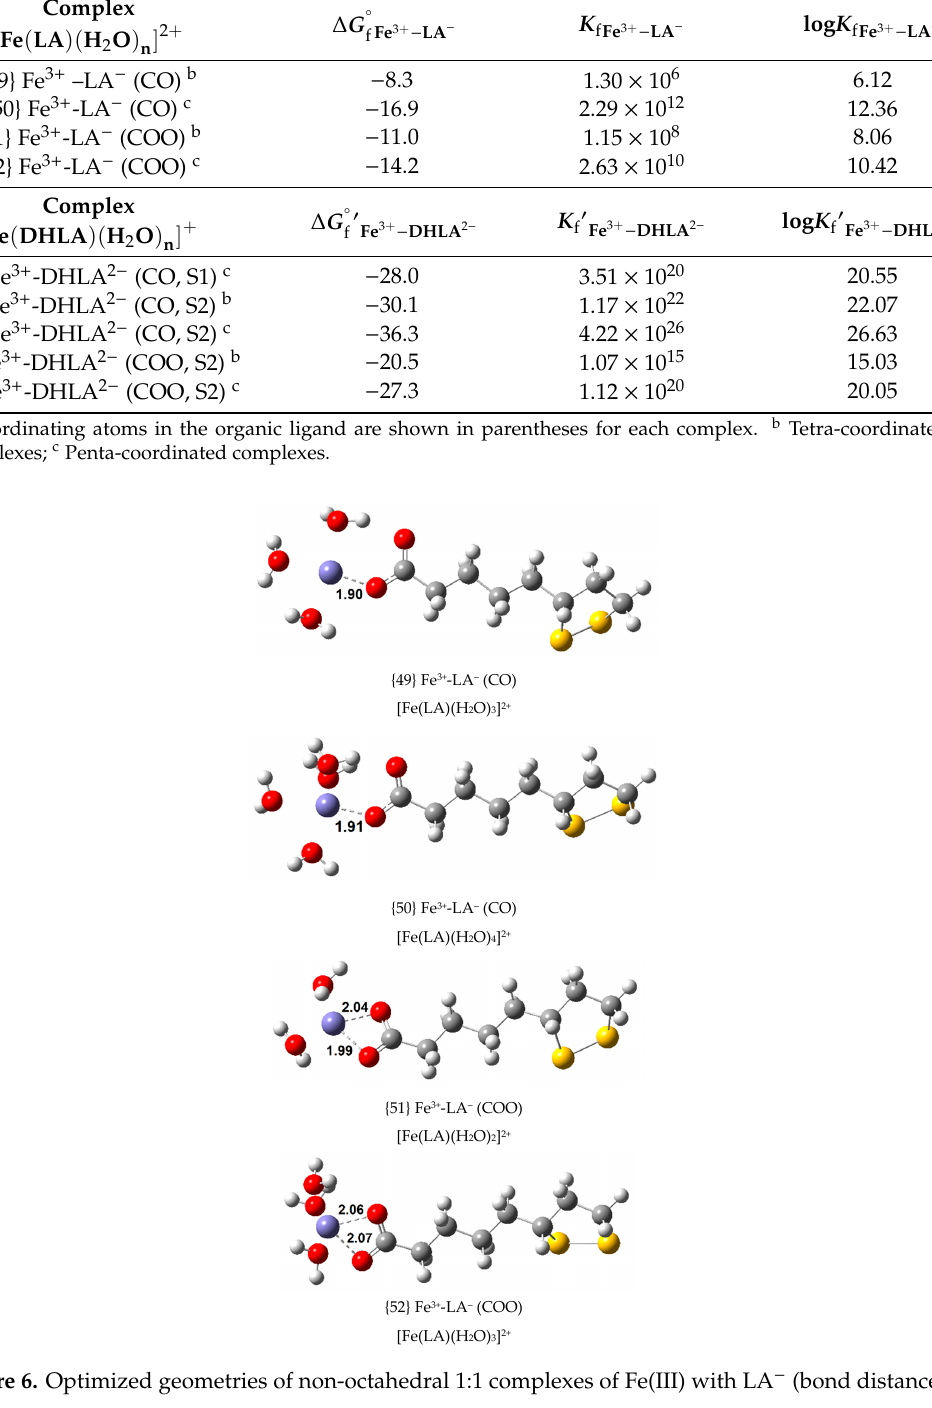
◦ , in kcal / mol) and formation constant ( K f , log K f ) for f